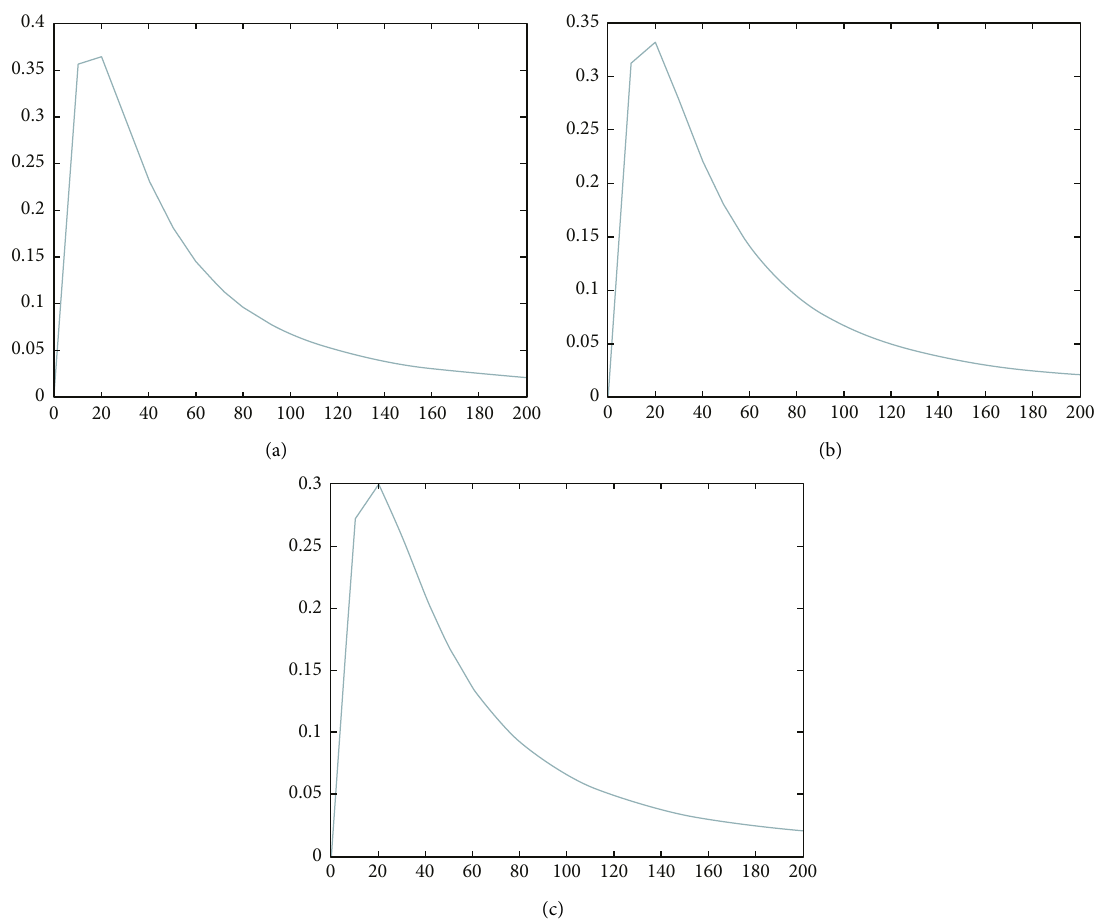
Figure 9: Characteristics of shear stress in overlying strata. (a) 10m, (b) 15m, (c) 20m. (The abscissa is the height, and the ordinate is the shear stress).